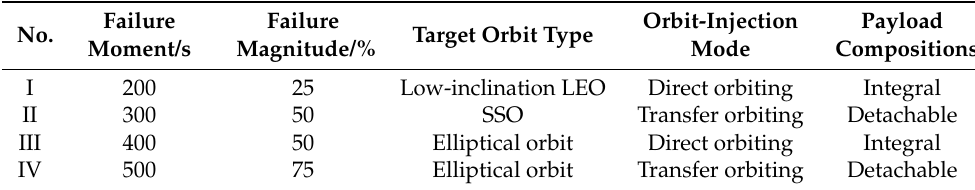
Table 3. List of fault